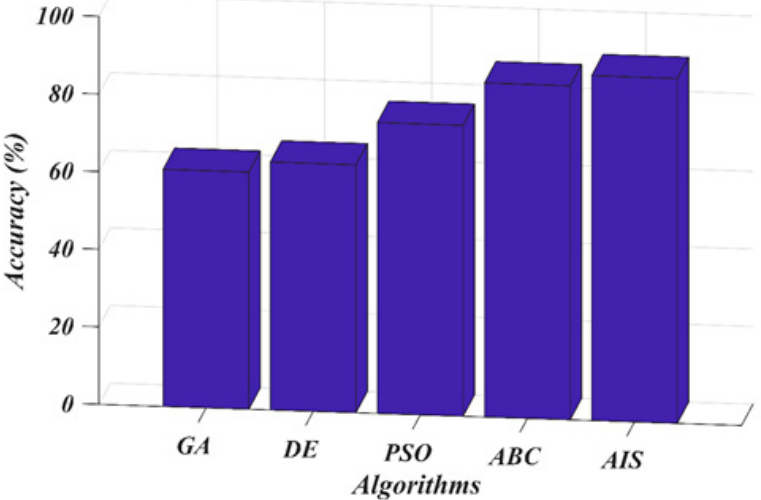
Figure 11. Accuracy Evaluation for Car Evaluation.